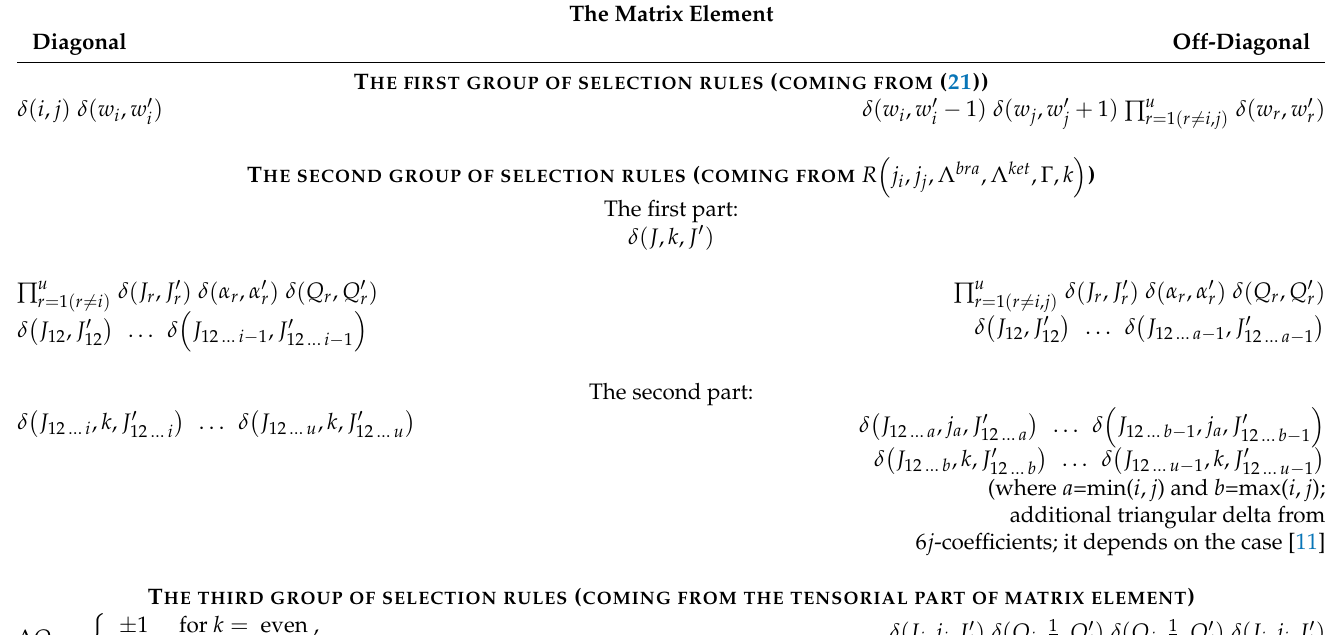
Table 2. Selection rules for one-particle nonscalar operator with rank k in jj -coupling. The Matrix Element